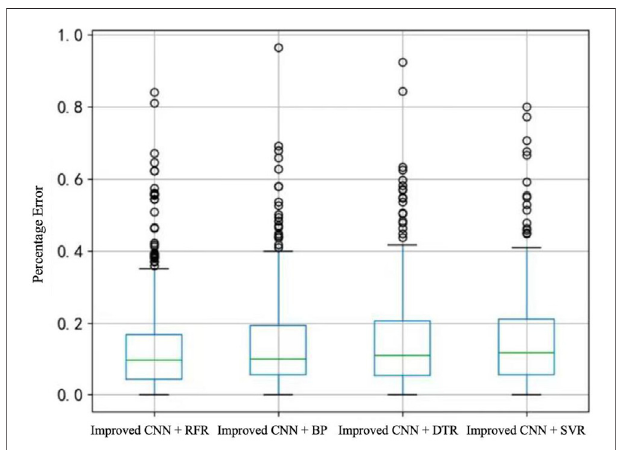
FIGURE 10 | Error box diagram of forecasting results by different numerical forecasting methods.